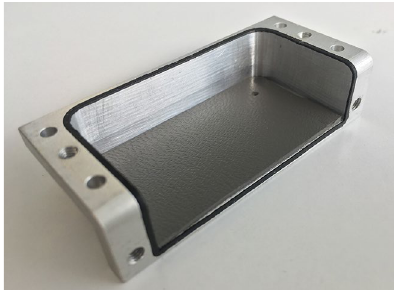
Figure 6. Oscillator enclosure with